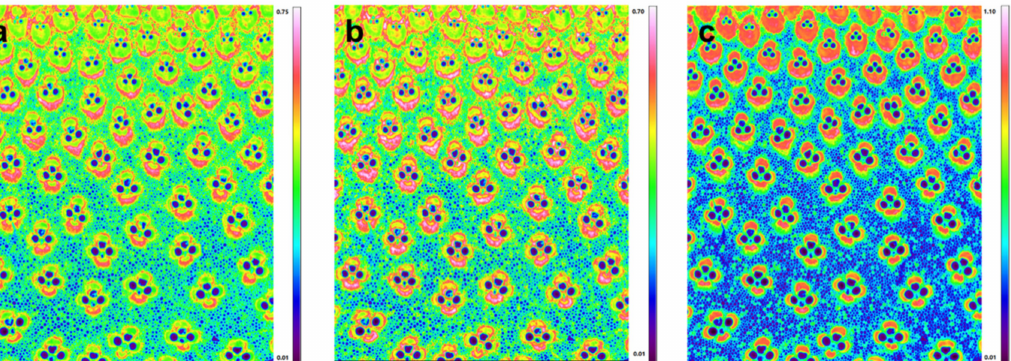
Figure 2. FT-IR images of the relative concentration and distribution of xylan ( a ), lignin ( b ), and cellulose ( c